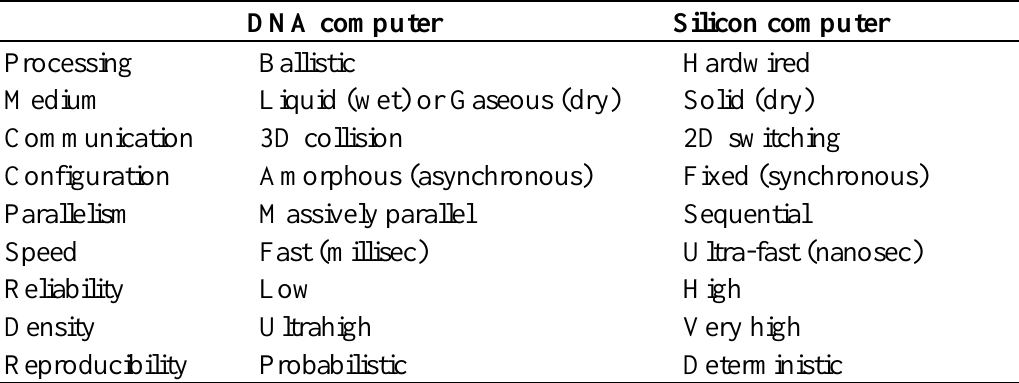
Table 1. Comparison of DNA and Silicon based computer